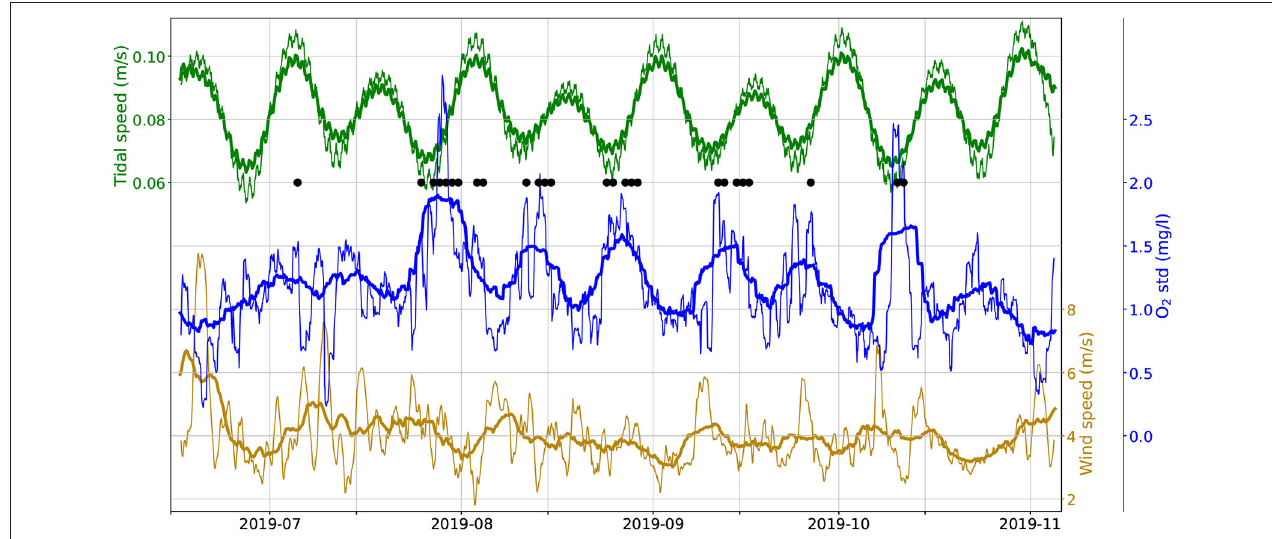
FIGURE 4 | Moving standard deviation of observed bottom O 2 concentration ( middle , blue) along with the moving mean of tidal speed (0.4x TPXO model, green, top ) along with the moving mean of wind speed (ERA5 reanalysis, dark yellow, bottom ). Thick lines use a 1-week window, thin lines use a 1-day window). Black dots mark hypoxia events.